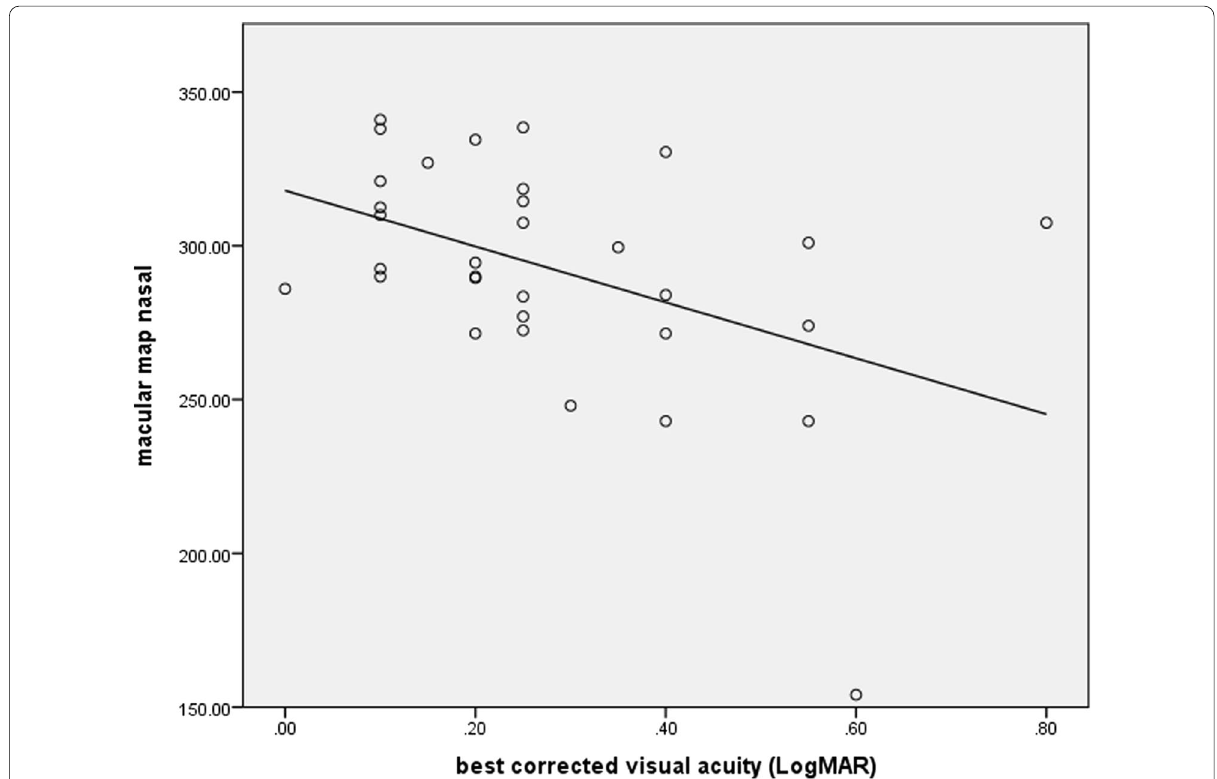
Fig. 1 Correlation between visual acuity and OCT parameters. OCT optical coherence tomography